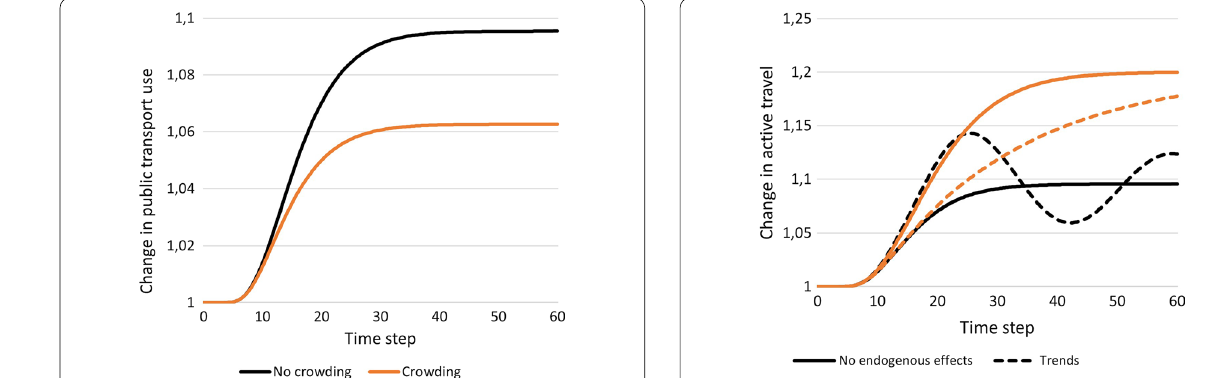
Fig. 2 Intervention effect with and without the crowding effect